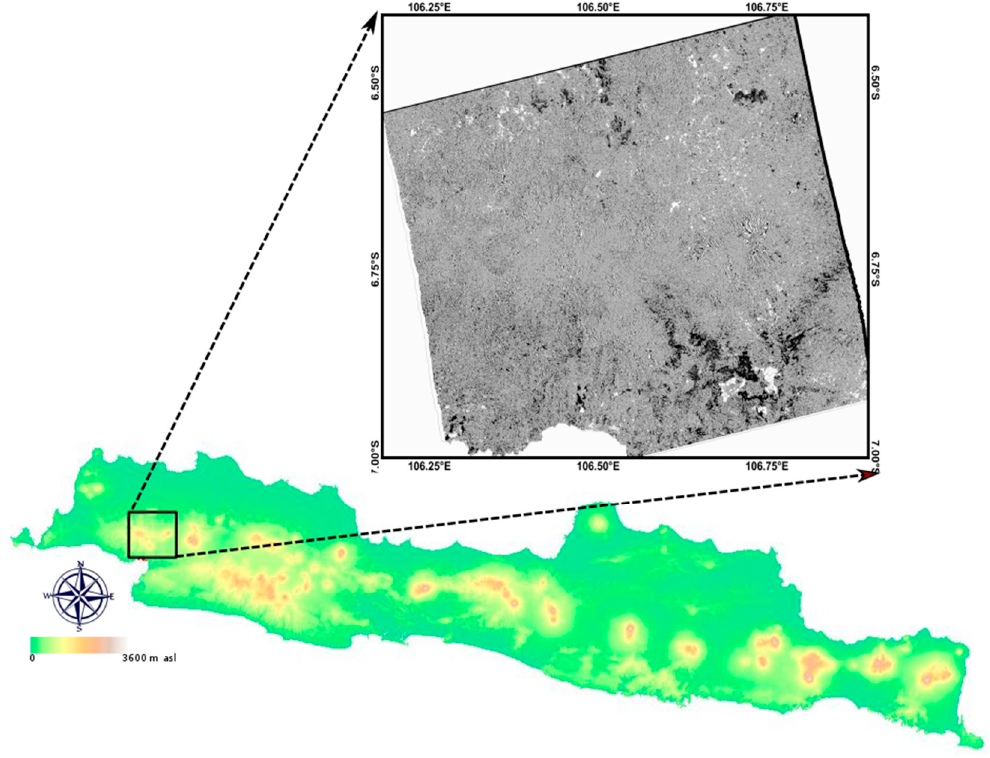
Figure 1. Site for change detection using dual polarimetric Advanced Land Observing Satellite Phased-Array type L-Band Synthetic Aperture